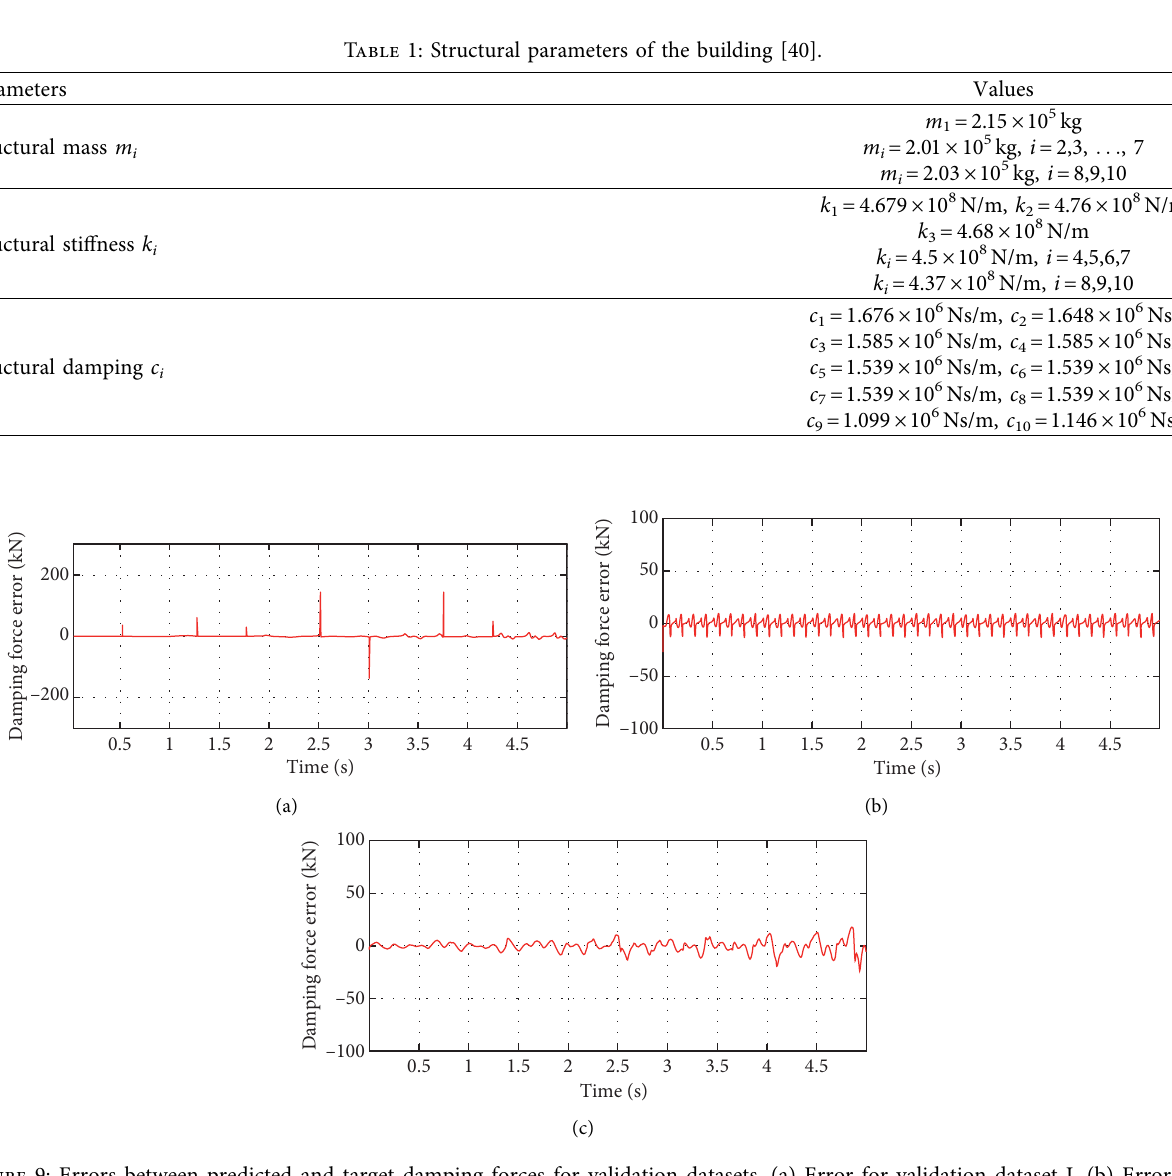
Figure 9: Errors between predicted and target damping forces for validation datasets. (a) Error for validation dataset I. (b) Error for validation dataset II. (c) Error for validation dataset